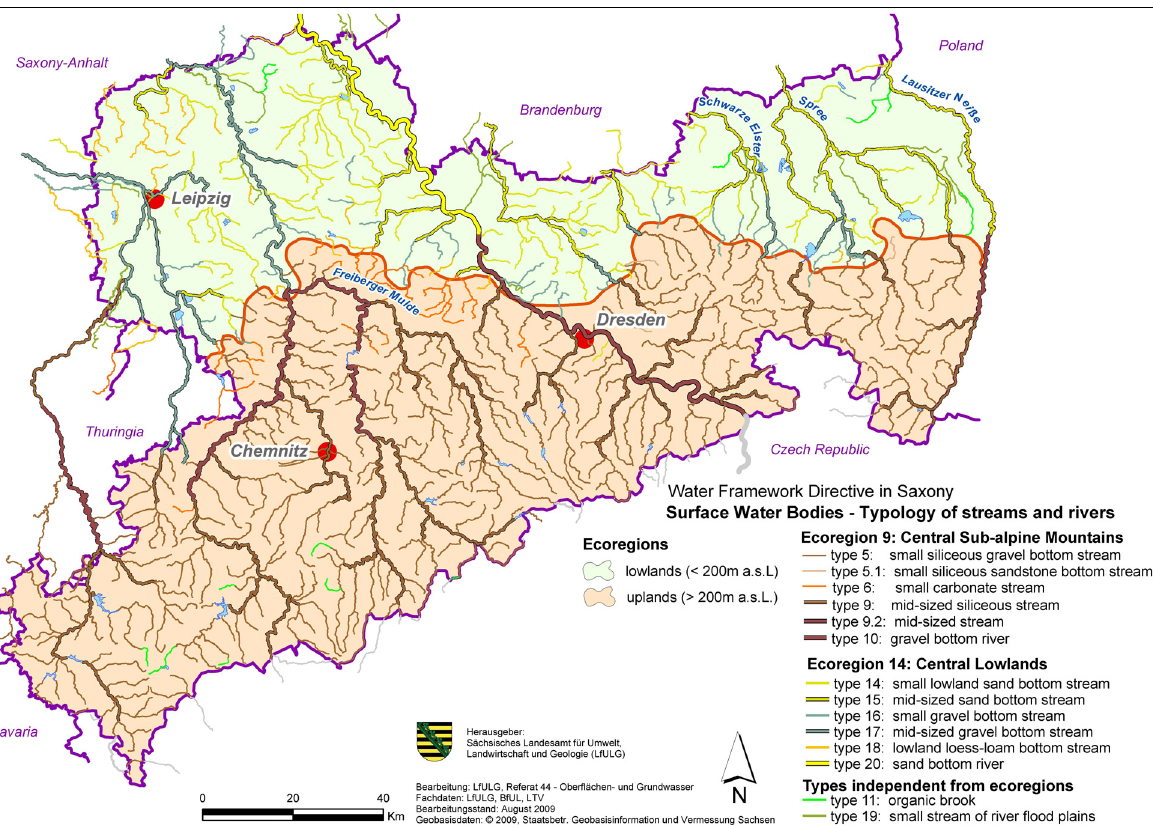
Figure 3. Stream types in